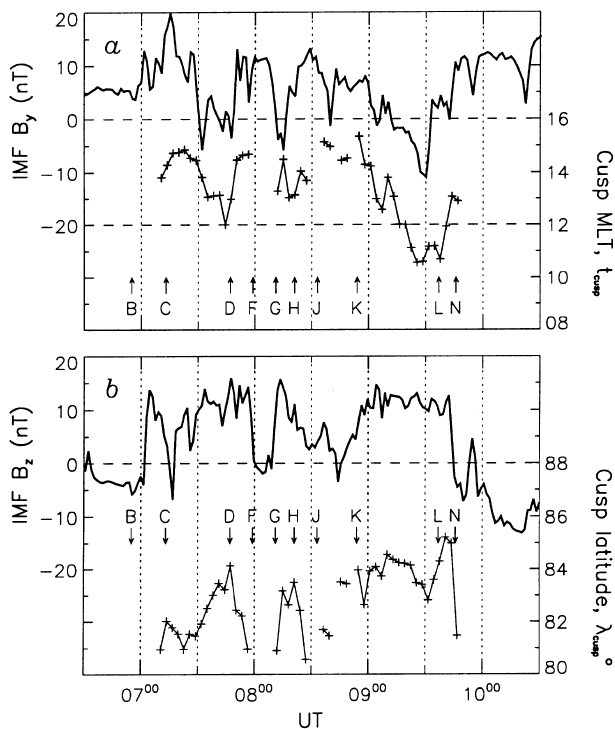
Fig. 3. Time series of the MLT and latitude of the centre of type 2 cusp emission (see text for details), compared with the B components of the IMF, as measured by the Wind MFI instrument, time-lagged by 21 min to account for the propagation delay in the solar wind. Lettered arrows correspond to images in